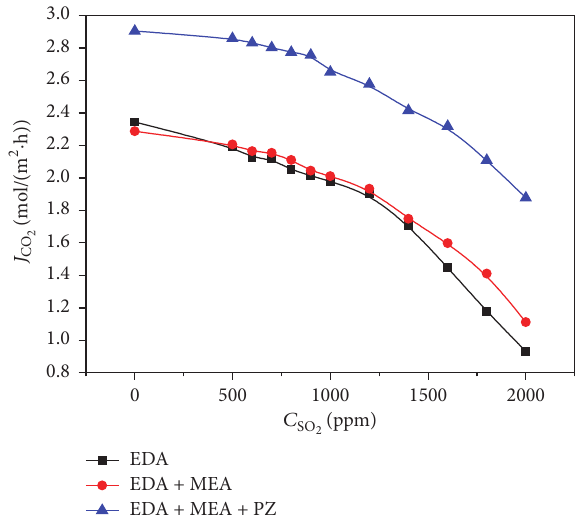
Figure 3: Influence of SO 2 concentration on the CO 2 mass transfer = 0.7 m 3 /h, and T = 288 K). rate ( 𝑈 𝑔 = 4 m 3 /h, U l